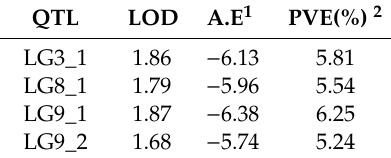
Table 4. E ff ects of the QTLs associated with the regeneration rate detected in F1 populations (GX50). QTL LOD